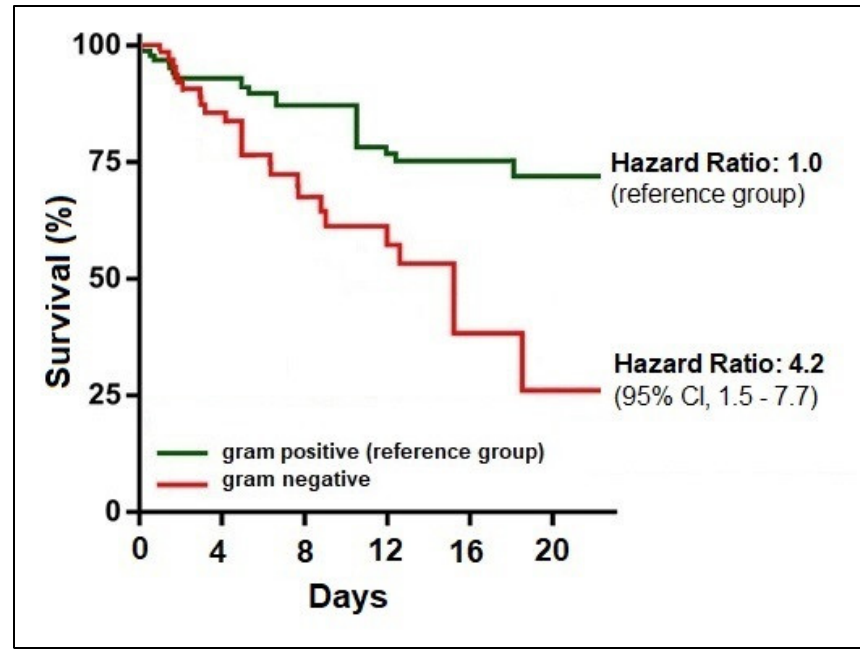
Figure 3. Kaplan–Meier probability curve for mortality by type of infection.